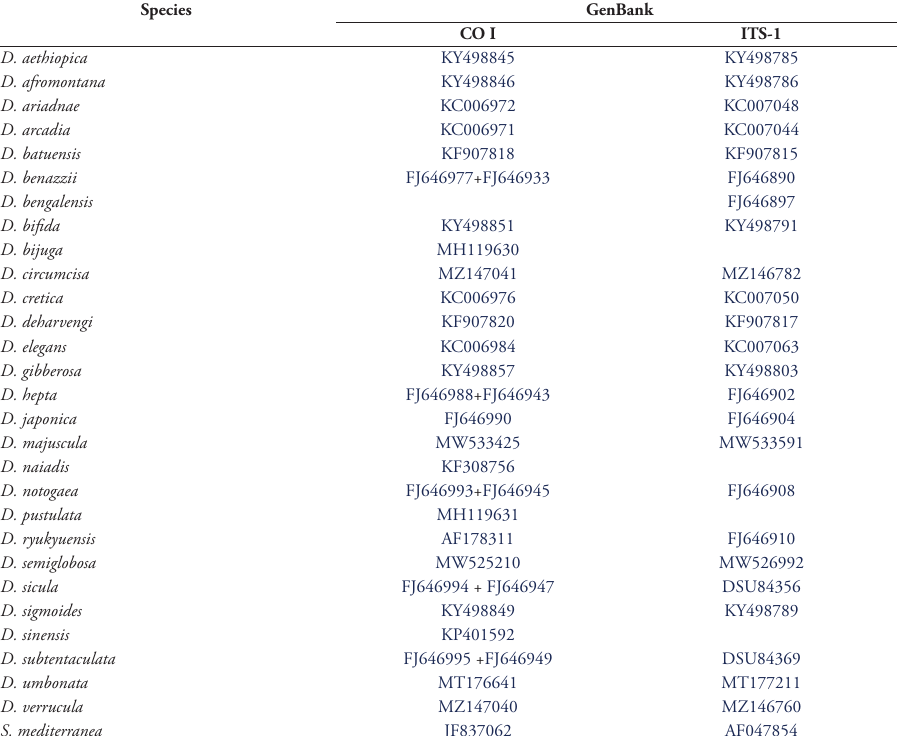
Table 1. GenBank accession numbers of COI and ITS-1 sequences used for molecular analyses. Species GenBank CO I